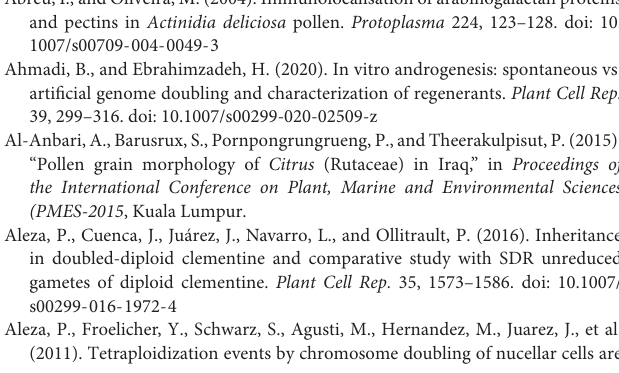
arrows. All scale bars = 25 µ m. Tapetum (t), MiMC (m), diploid (2x), and doubled diploid (4x). Supplementary Figure 4 | Inmunolocalization of pectins during microsporogenesis in diploid and doubled diploid “Sanguinelli” blood orange. Monoclonal antibody used: JIM5 against unesterified pectins. (A,C) Unesterified pectins present in the remaining part of the microspore mother cell (MiMC)